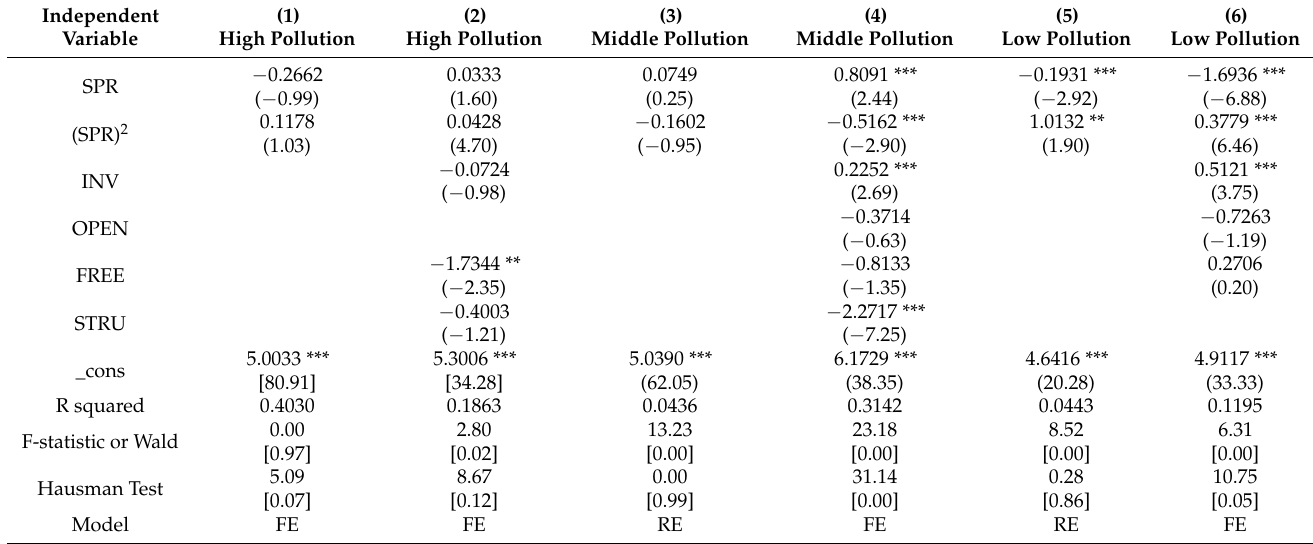
Table 7. Estimation results of subgroups categorized by environmental